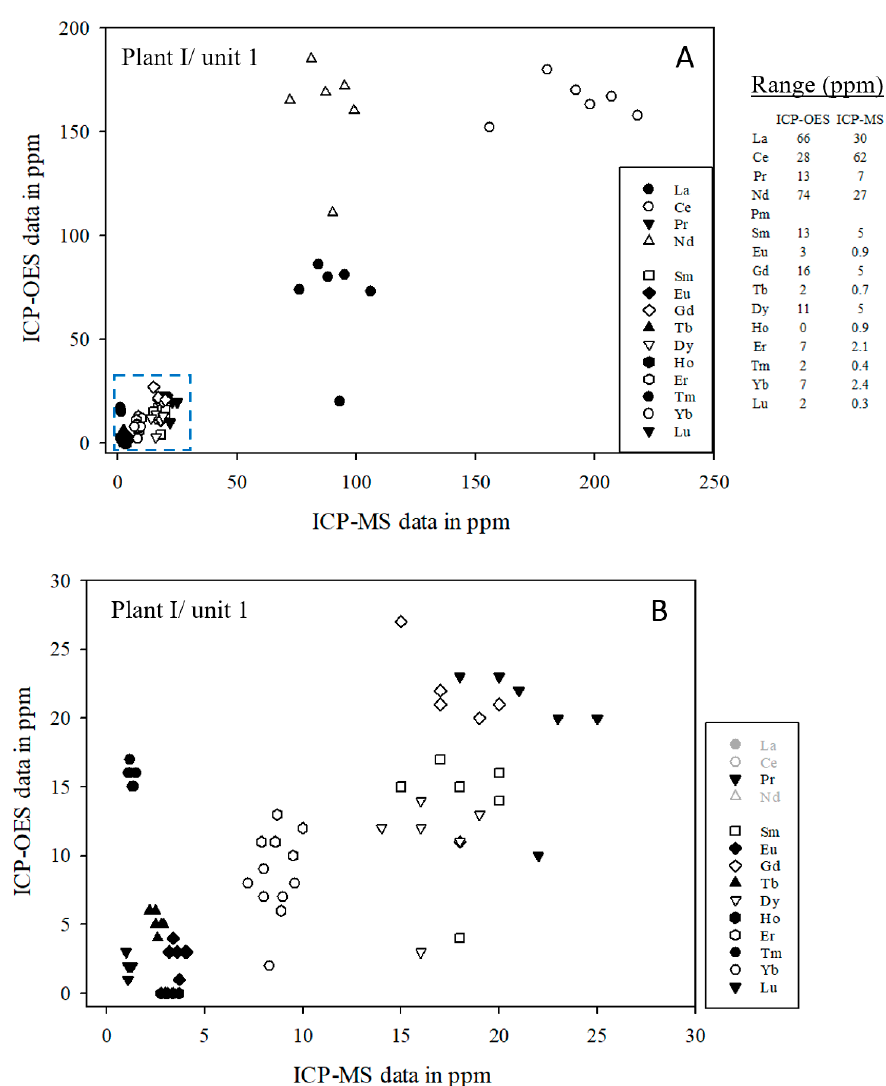
Figure 1. ( A ) Comparison of ICP-OES and ICM-MS analyses for rare earth element contents in samples 94012–94019 (series 4). ( B ) A subset of the data, within blue outline in panel ( A ), focused on the lower abundance (and heavier) REE. Note that La, Ce, and Nd do not appear in this portion of the graph.